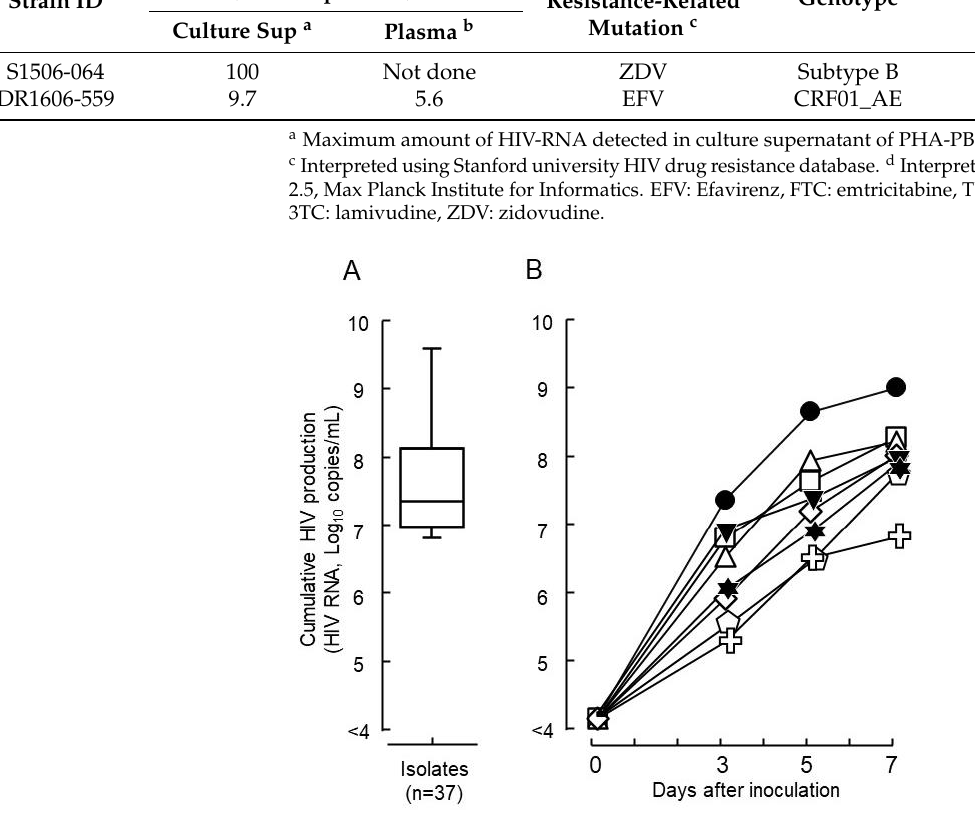
Figure 1. Growth capabilities of HIV epidemic isolates. ( A ) The wide distribution of growth capa- bilities was determined for the 37 clinical isolates tested and shown using production levels in cul- ture with phytohemagglutinin-activated peripheral blood mononuclear cells for 7 days in vitro (mean ± standard error). ( B ) In vitro viral growth kinetics in the culture are shown for seven repre- sentative HIV isolates and one laboratory strain of HIV ( ● DR1509-397, ▼ DR1605-400, ⬠ S1506-064, ◻ DR1606-521, △ DR1510-726, ◇ DR1606-479, DR1606-559, and pNL4-3). Closed symbols de- note drug sensitive isolates and open symbols denote drug-resistant isolates against tested nucleo- side/nucleotide transcriptase inhibitors. Non-nucleoside/nucleotide reverse transcriptase inhibitors, and protease inhibitors based on the Stanford university HIV drug resistance database genotype- phenotype comparison scores. Table 1. Characteristics of seven representative strains tested for drug response.